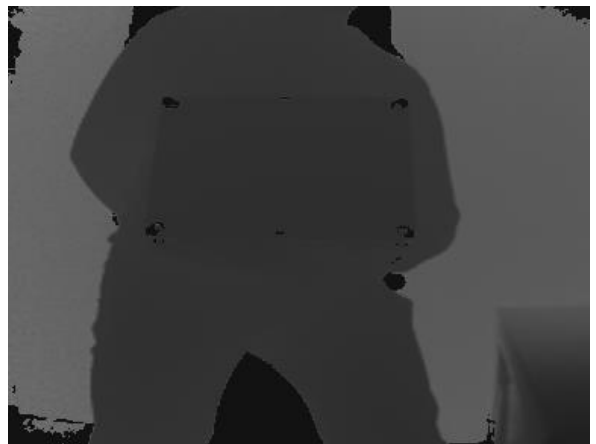
Figure 8. Denoised depth image with noisy pixels marked out. Applying the peakiness test, the depth image is segmented into discrete depth layers (Fig. 9). The histogram shows the depth value distribution in blue and the thresholds in red. In the resulting discrete depth layer image (Fig. 9 right) the person is totally covered in one depth layer. The same layer is also assigned to a part of the table on the right side.